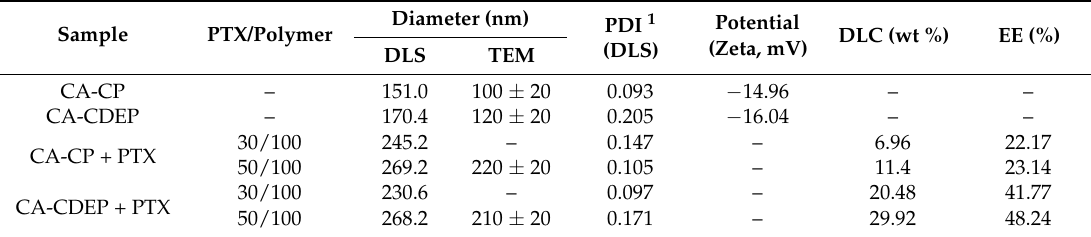
Table 2. Diameter, PDI, zeta potential, DLC, and EE of micelles.